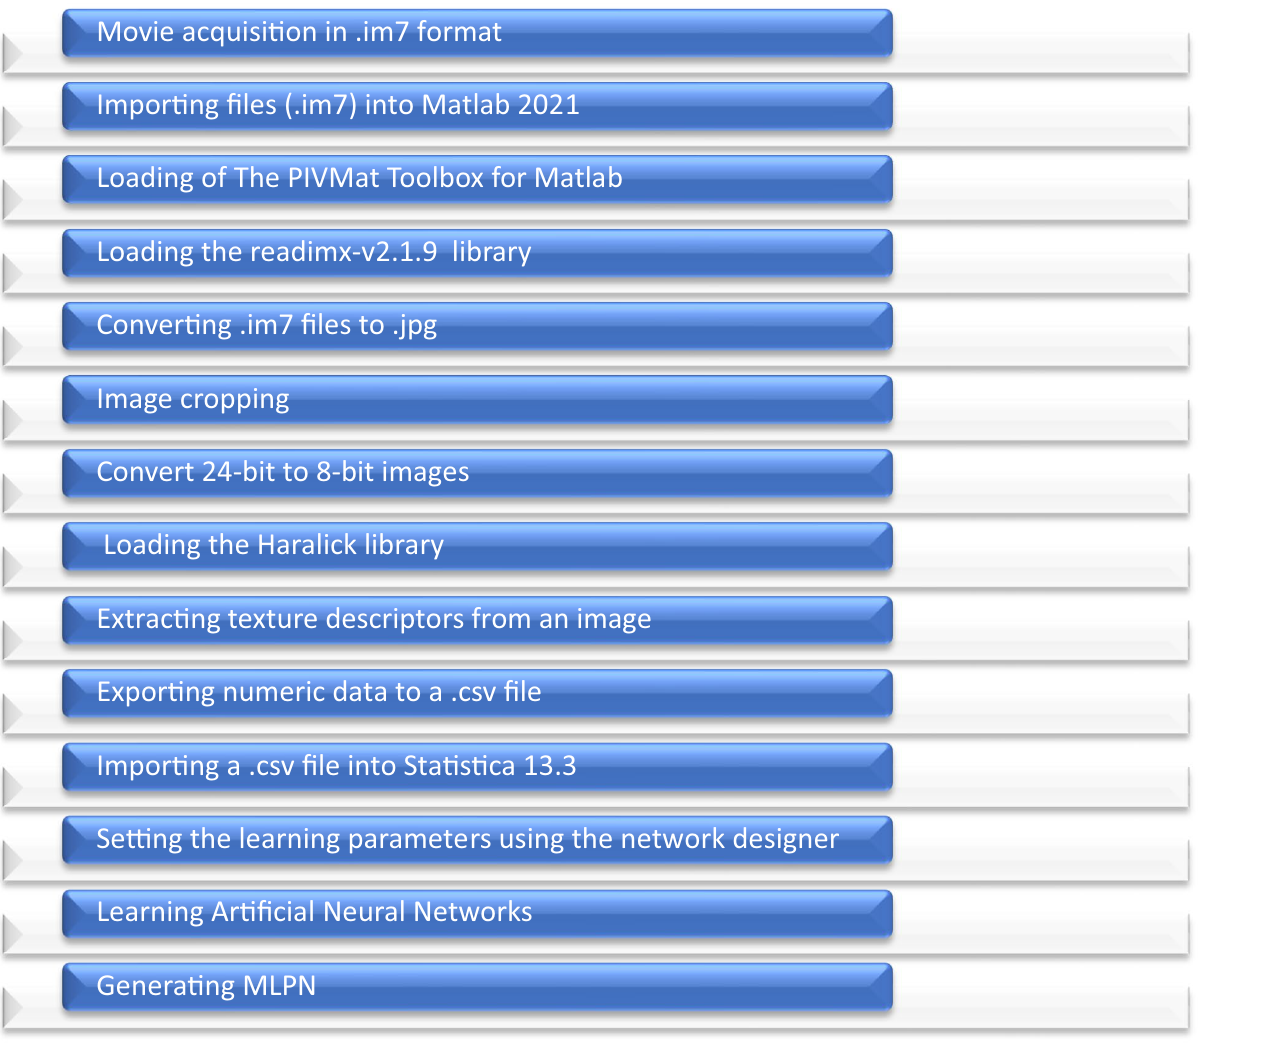
Figure 2. The scheme of image processing and creation of Artificial Neural